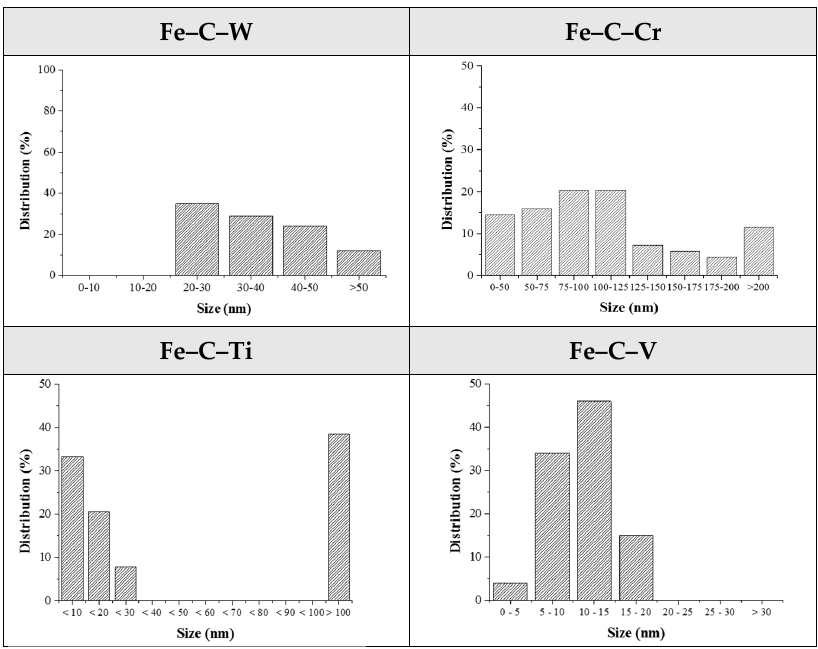
Figure 3. Carbide size distributions for the different alloys.